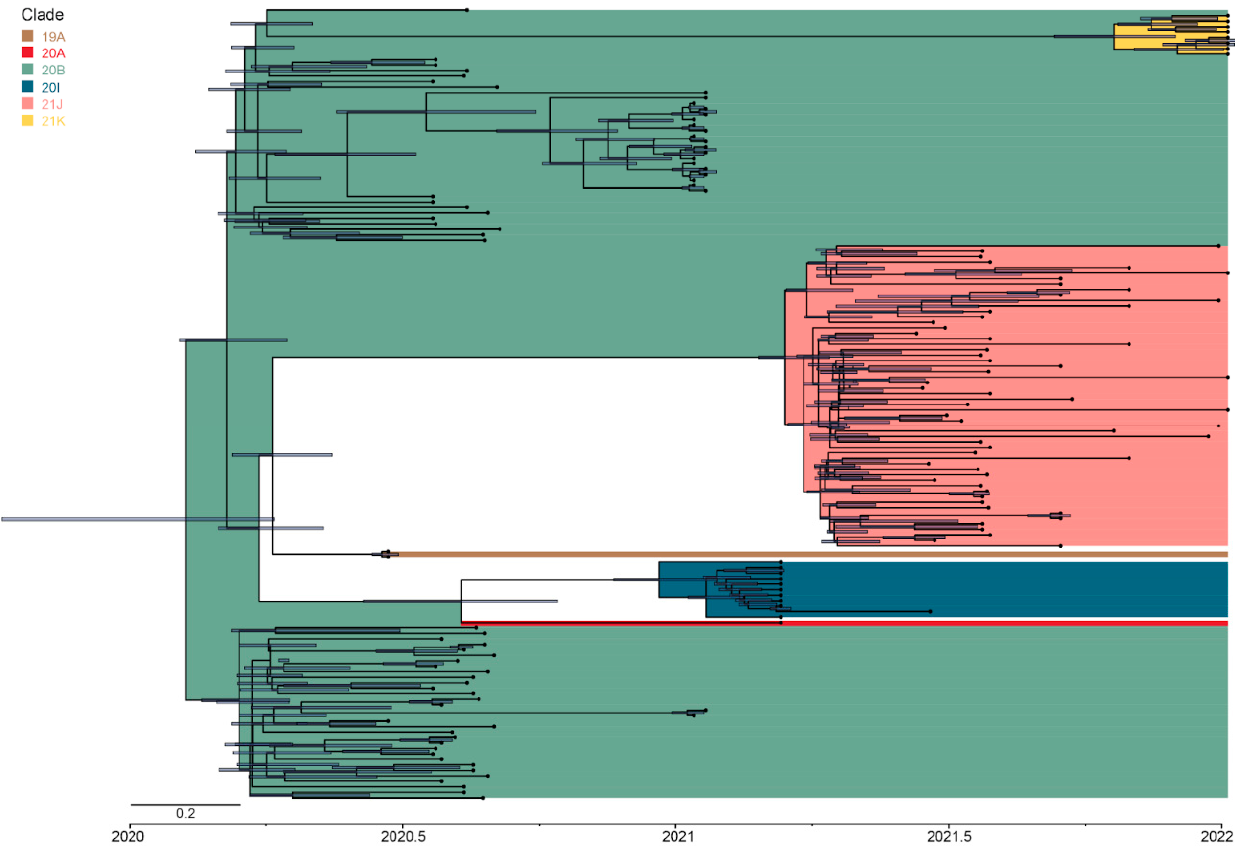
Figure 3. Annotated MCC tree of Armenian sequences. Background colors indicate Nextstrain clades; tip labels indicate PANGO lineages. Bars at nodes represent 95% height posterior density.